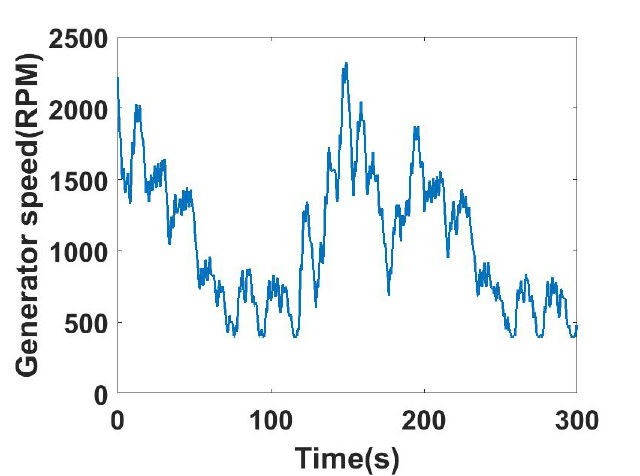
Figure 14. The generator speed.